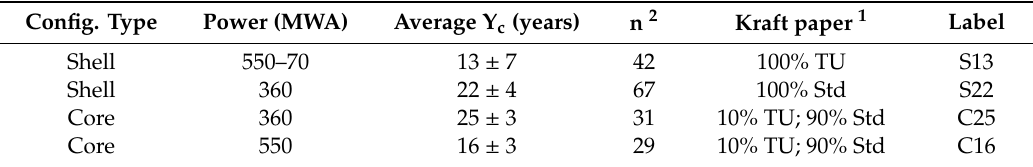
Table 3. Characteristics of the transformers investigated [2].